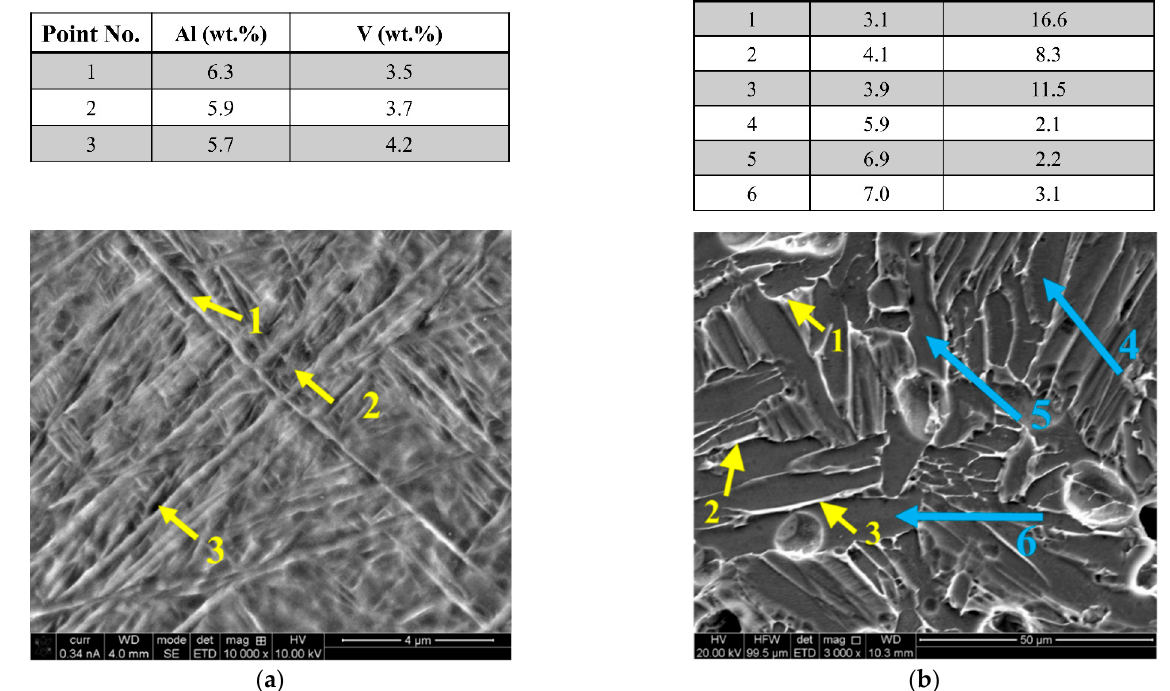
Figure 7. EDS analysis of ( a ) as-built L-PBF fabricated part, ( b ) PM sample (750 MPa/1250 °C).